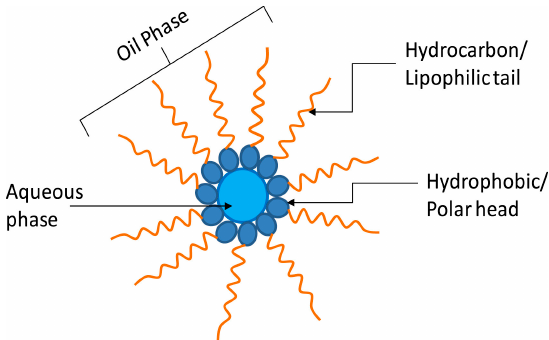
Figure 5. W/O type reverse micelle micro emulsion [59].